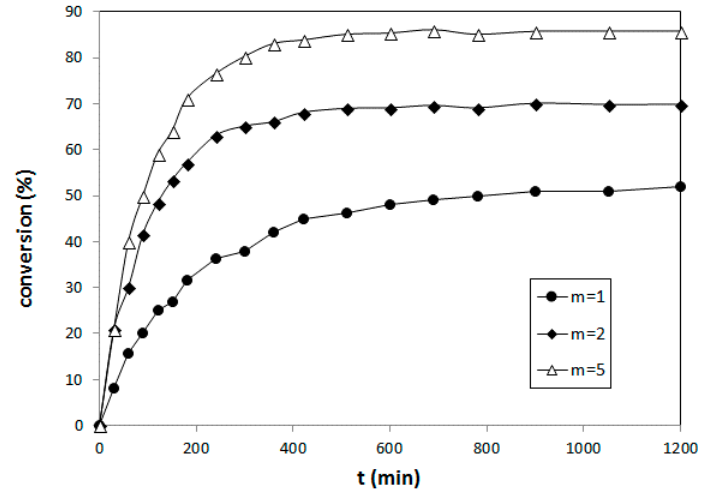
Figure 6. Conversion profiles versus time for the uncatalyzed esterification of lauric acid with methanol at 150 °C and different acid:alcohol molar ratios.